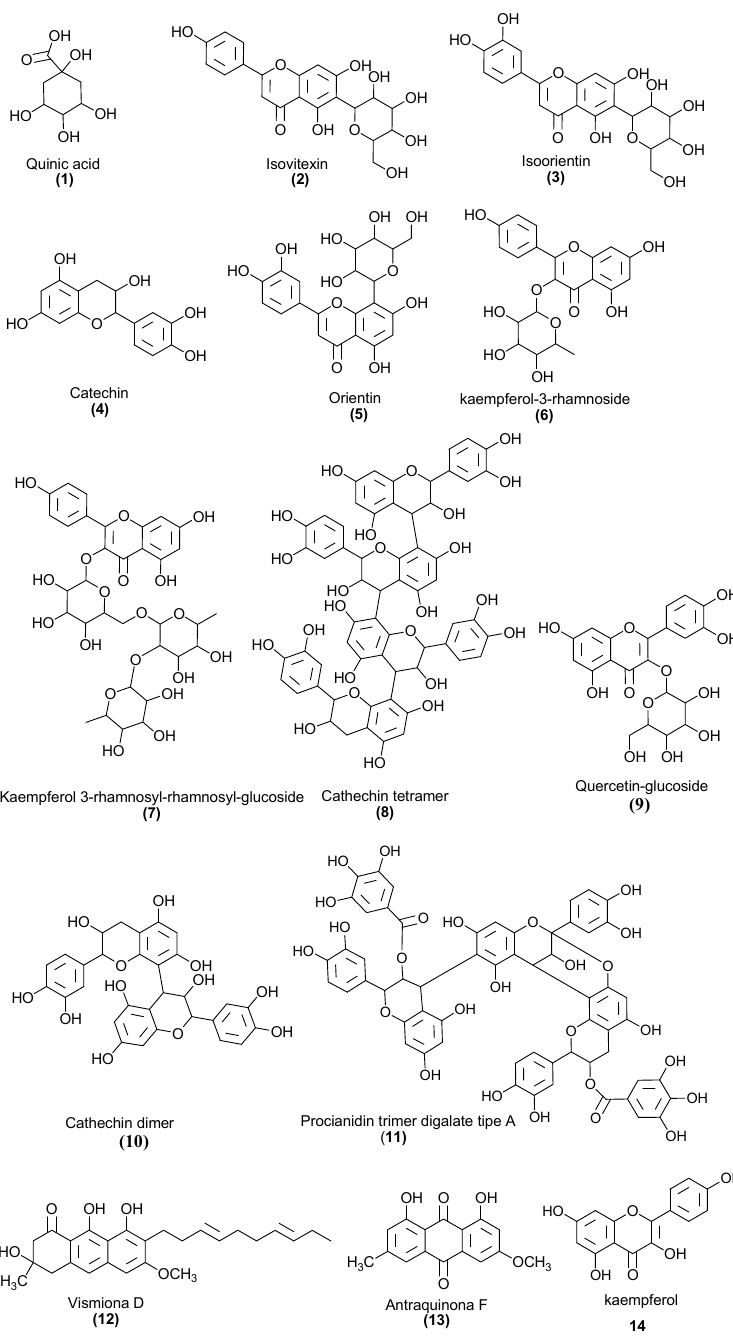
Figure 4. Chemical structures of the compounds identified in the Vismia guianensis leaf extract.